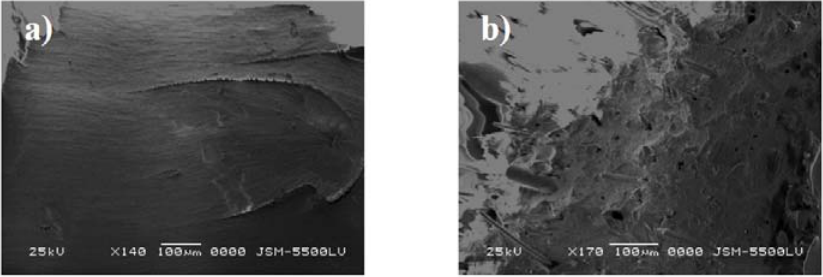
Figure 14. Shear mode in wear test. ( a ) ABS; ( b )